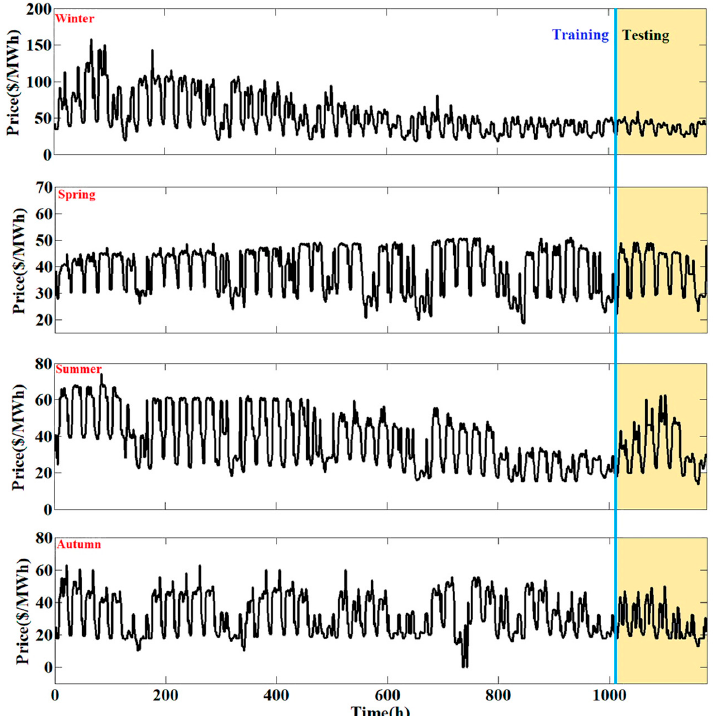
Figure 3. The hourly training and testing data for the electricity market of Spain in 2019.